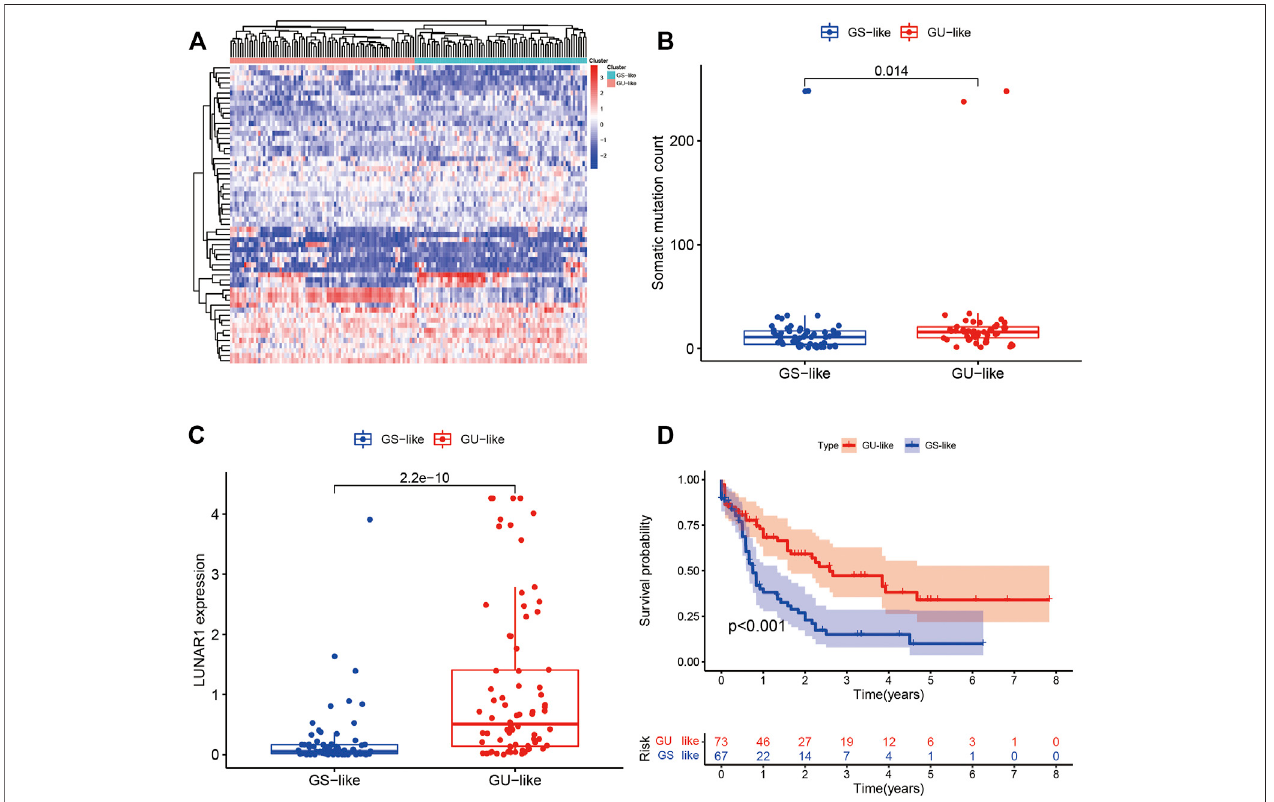
FIGURE 7 | (A) Heat map of all samples after the cluster analysis. The X -axis is the sample type, blue represents the genomic stable type and red represents the genomic unstable type. The Y -axis represents differentially expressed lncRNAs, red represents upregulation, and blue represents downregulation. (B) Box diagram of the mutation frequencies of the two types. (C) Expression map of the two types of LUNAR1. (D) Kaplan – Meier curves of the GU-like and GS-like groups. In the Kaplan – Meier curveofdifferentsomatic mutation count ofpatients with AML,the X- and Y -axes represent thetimeand probability ofsurvival, whereas the red and blue lines represent the GU-like and GS-like groups,